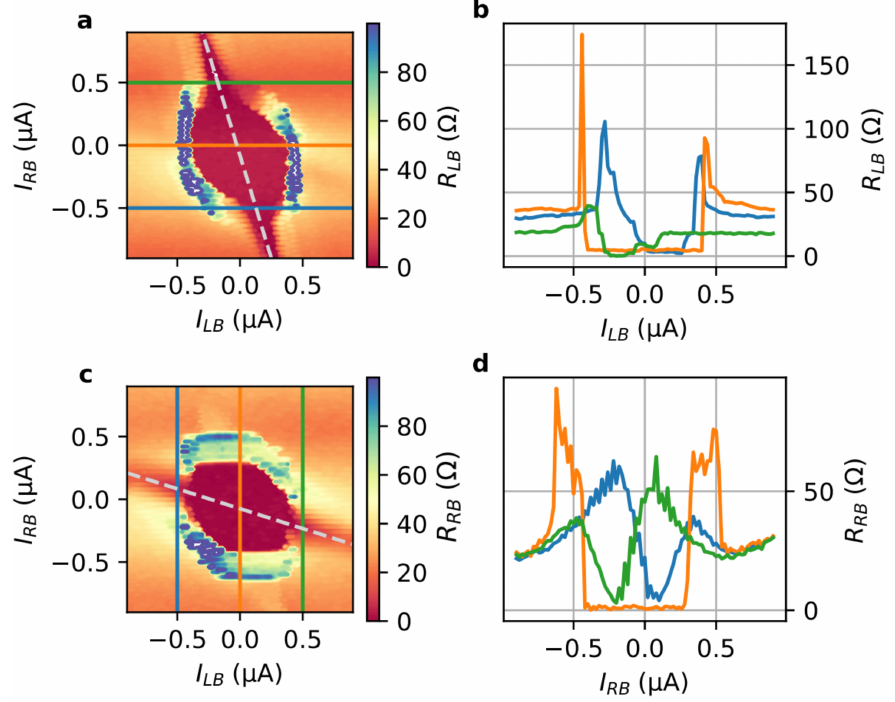
Figure 2. Differential resistance maps: ( a ) R LB as a function of the bias currents I LB and I RB at 25mK with corresponding line cuts given in ( b ). In ( c ), the differential resistance map of R RB is depicted with a selection of line cuts given in ( d ). The dashed lines in ( a , c ) indicate the superconducting regions of compensating bias currents. The differential resistances were measured using the lock-in technique, i.e., R LB = ∆ V LB / ∆ I LB and R RB = ∆ V RB / ∆ I RB